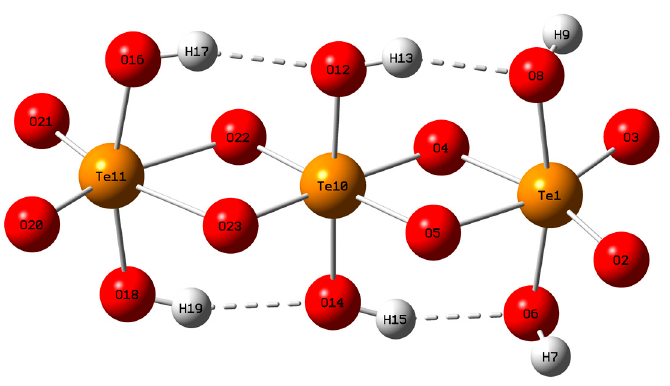
Figure 5. Optimized geometry of LT anion [Te 3 O 12 H 6 ] 4 − . H-bonds are shown as dashed lines.